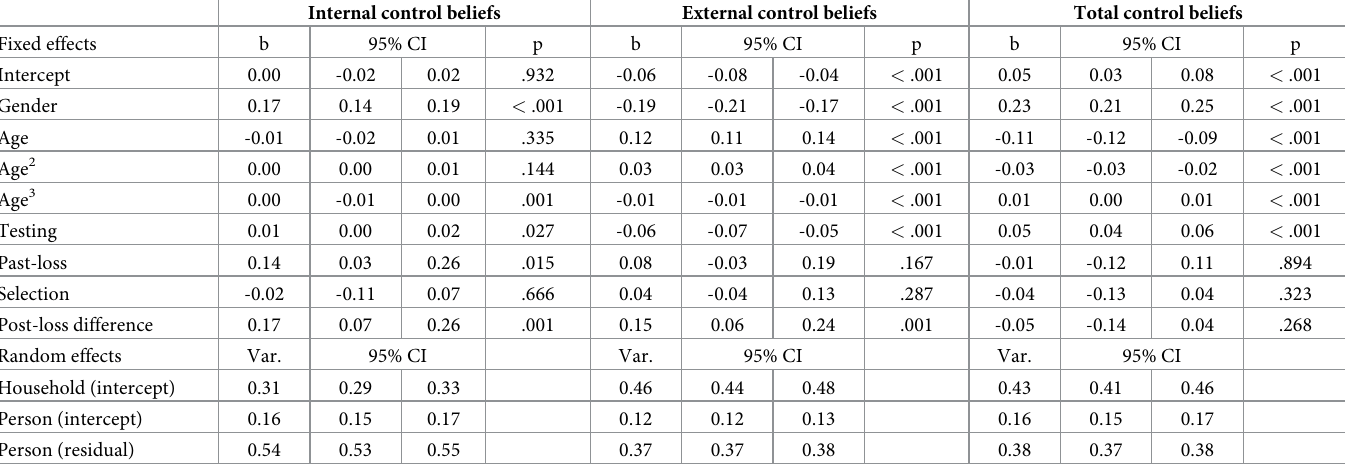
Table 6. Differences in perceived control between individuals who did ( N = 437) and did not ( N = 14,335) experience the death of a partner between 1991 and 1999 ( N = 14,772). Internal control beliefs